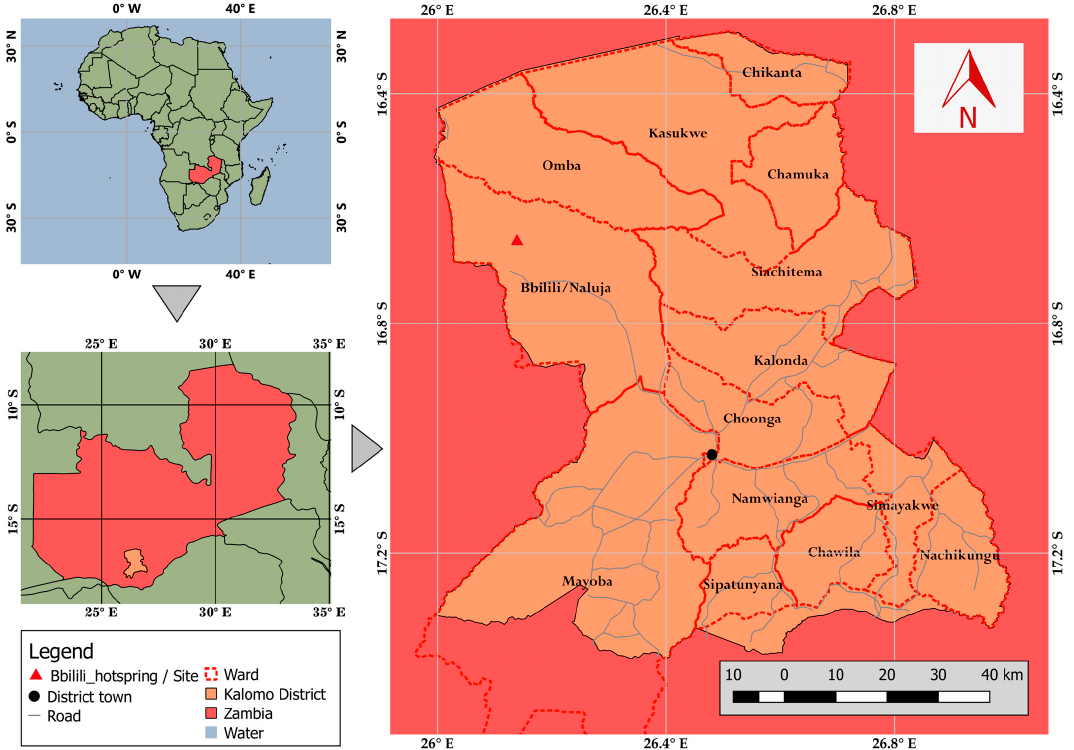
Figure 1. Location and administrative map of the Kalomo District in the Southern Province of Zambia (Source: Prepared by Bravedo M. Mwaanga/CIFOR). Known as the “ Land of Maize and Cattle ” [73], the local economy of the Kalomo District relies strongly on agriculture, with key crops including maize, sorghum, groundnuts, millet, cotton, and tobacco [74]. The rapidly growing population and persistent poverty have increasingly put pressure on forests and land over time, and, for example, the Kalomo Hills Local Forest Reserve (KFR) has suffered from significant deforestation and degradation due to expanding cultivation of crops [73]. The Kalomo District is also referred to as the “ Farmer’s Nest ” because of the commercial, medium- to small-scale livestock and crop farming enterprises that exist there. Sales of crops, livestock and fisheries products, as well as fruits and vegetables, contribute about 50% of local household incomes, with contributions of 34.4%, 9%, and 7.8% from crops, livestock and fisheries, and fruits and vegetables, respectively. Alternative incomes come from the collection of natural products (wild fruits, mushrooms, and honey) and the sale of fuelwood, charcoal, and handicrafts [73,74]. Livestock production consists of traditional (Indigenous) (50%) and commercial (50%) methods, with a total population of 411,765 animals [73]. This population gives a cattle/capita ratio of 0.44. Besides cattle, the rearing of goats, sheep, poultry, and pigs is also commonplace [73,75]. Crop production in the district is carried out at the subsistence level, complemented by limited semi-commercial and commercial farming. Maize is the primary staple crop and occupies 61% of the cultivated area. Both landraces and hybrid maize varieties are cultivated. The distribution of land area among crops in the district is Indigenous maize